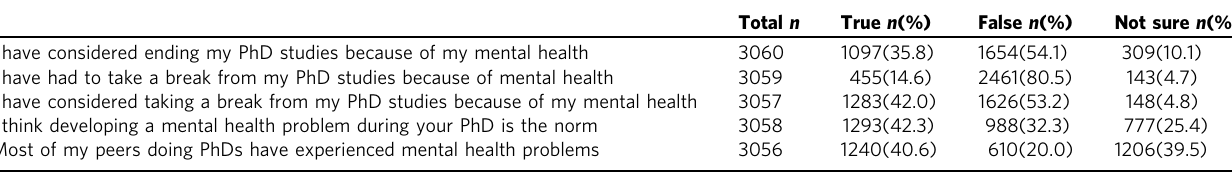
Table 2 The percentage of DRs who endorsed statements related to experiencing mental health problems while studying for a PhD.